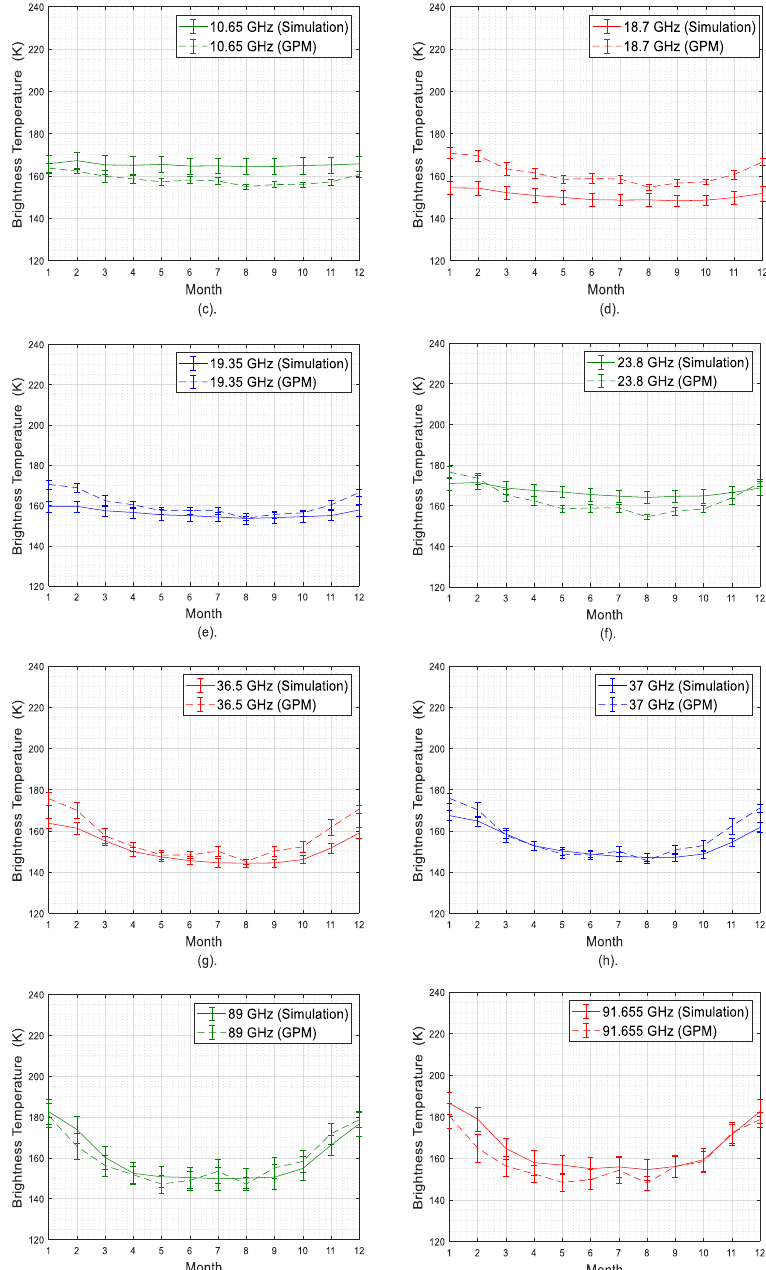
Figure 11. Horizontally measured polarized brightness temperatures over Concordia Station versus simulations as described in Section 3.1.2 at frequencies ( a ) 6.9 GHz; ( b ) 7.3 GHz; ( c ) 10.65 GHz; ( d ) 18.7 GHz; ( e ) 19.35 GHz; ( f ) 23.8 GHz; ( g ) 36.5 GHz; ( h ) 37 GHz; ( i ) 89 GHz, and ( j ) 91.65 GHz.